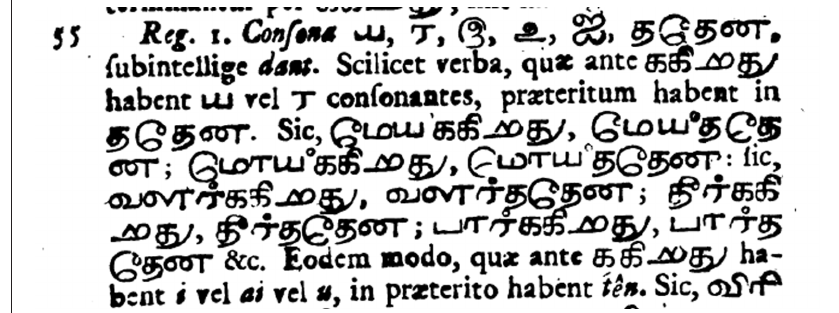
Figure 15: Beschi 1738: 50, (Cap. III, §. II, parag. 55, Præteritum, Regula